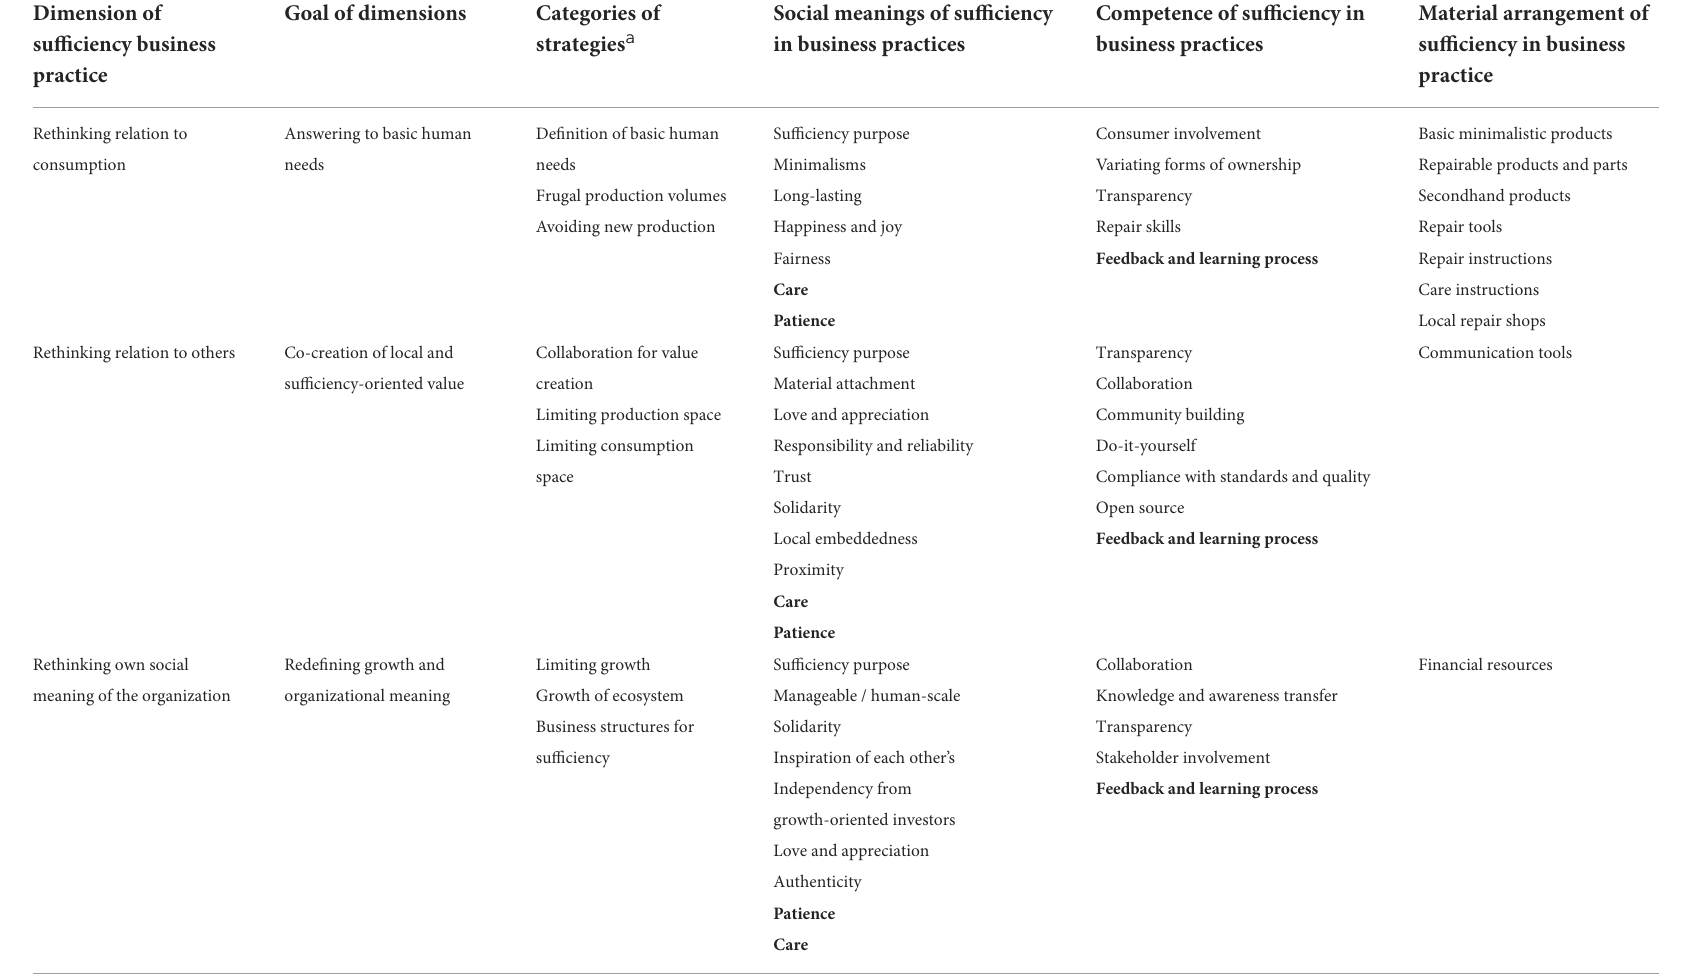
TABLE 4 Classification of codes according to the three dimensions of sufficiency in business practices. Dimension